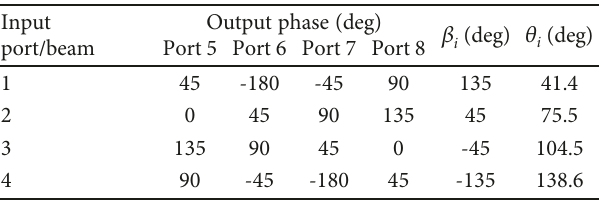
Table 1: Output phases, phase progressions β directions θ i of the 4 × 4